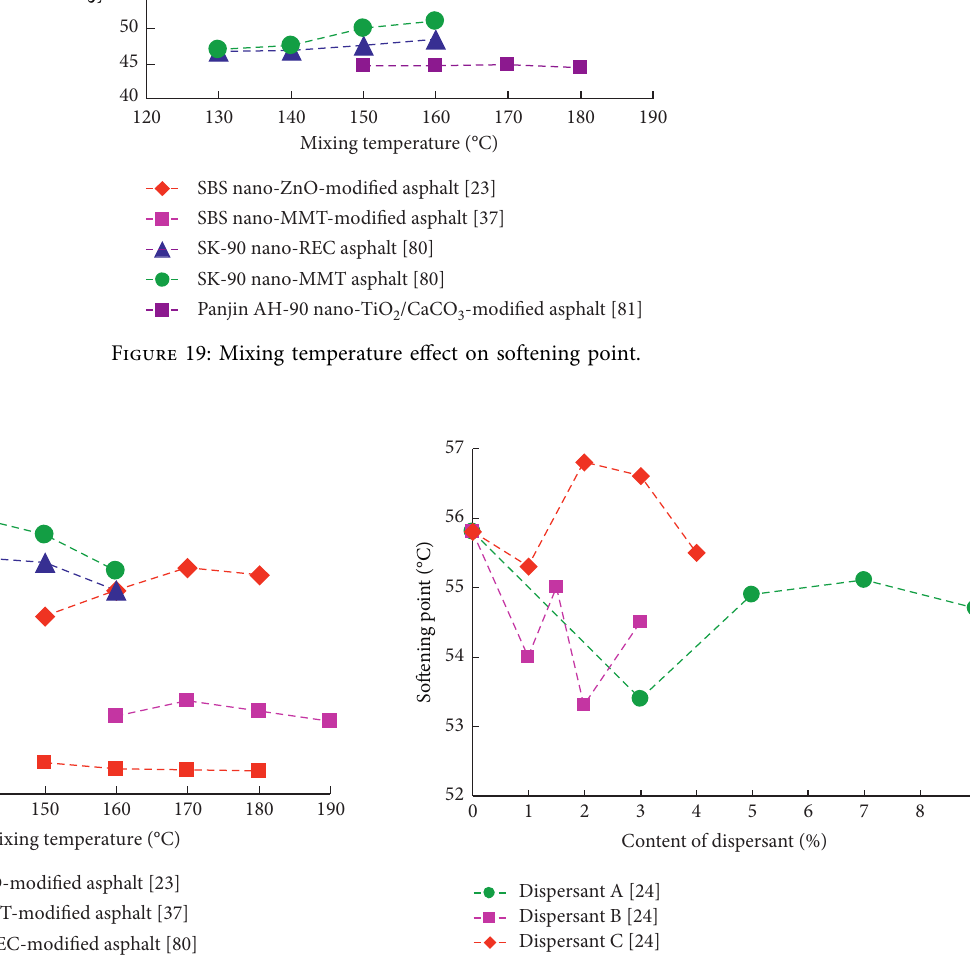
Figure 21: Dispersant effect on softening